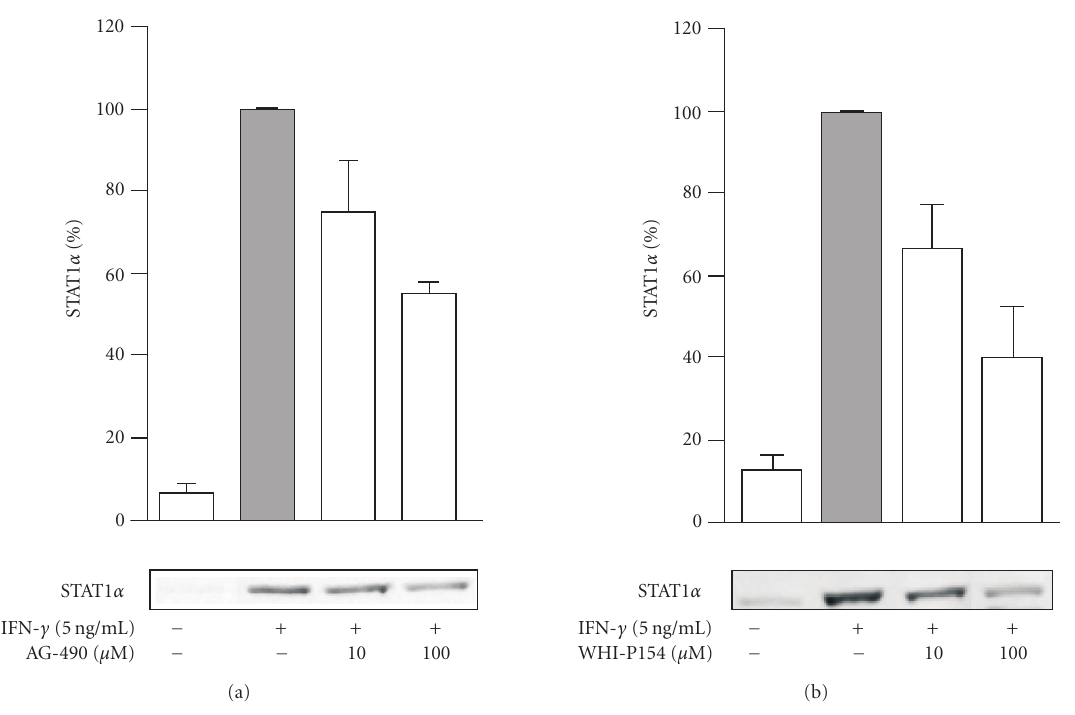
Figure 2: E ff ects of AG-490 and WHI-P154 on nuclear translocation of STAT1 α in IFN- γ -stimulated J774 macrophages. The cells were pretreated with (a) AG-490 or (b) WHI-P154 for 30 minutes. Thereafter, the medium was replaced with fresh medium containing the combination of the inhibitor and IFN- γ (5ng/mL). The cells were incubated for another 30 minutes, and the nuclear proteins were extracted as described in materials and methods. The protein content of the samples was measured and equal amounts (20 μ g) were subjected to immunoblot analysis with antibody against STAT1 α . The results are expressed as mean ± SEM ( n = 2–3 for AG-490 and n = 4 for WHI- P154).